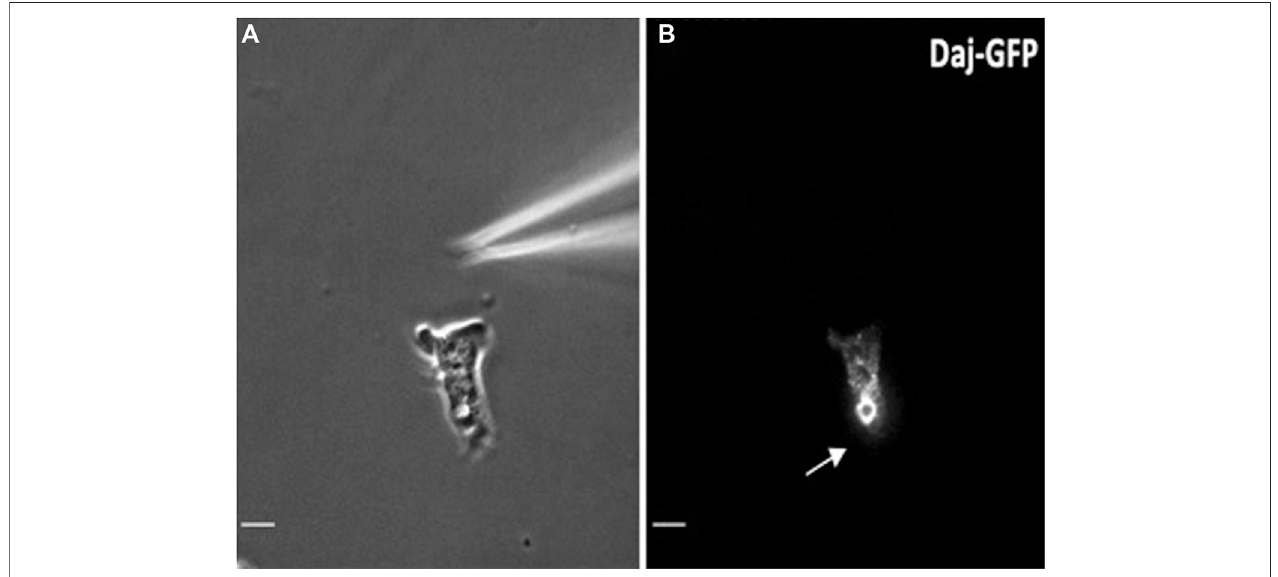
FIGURE1| TheCVislocalizedattherearofmigratingcells. (A) PhasecontrastimageoftheCVattherearofthepolarizedmigratingcell. (B) Thesamecellasin1C expressing Dajumin-GFP moving toward a micropipette fi lled with chemoattractant cAMP. Arrow indicates the localization of the CV. Courtesy of Fadil et al., 2022.